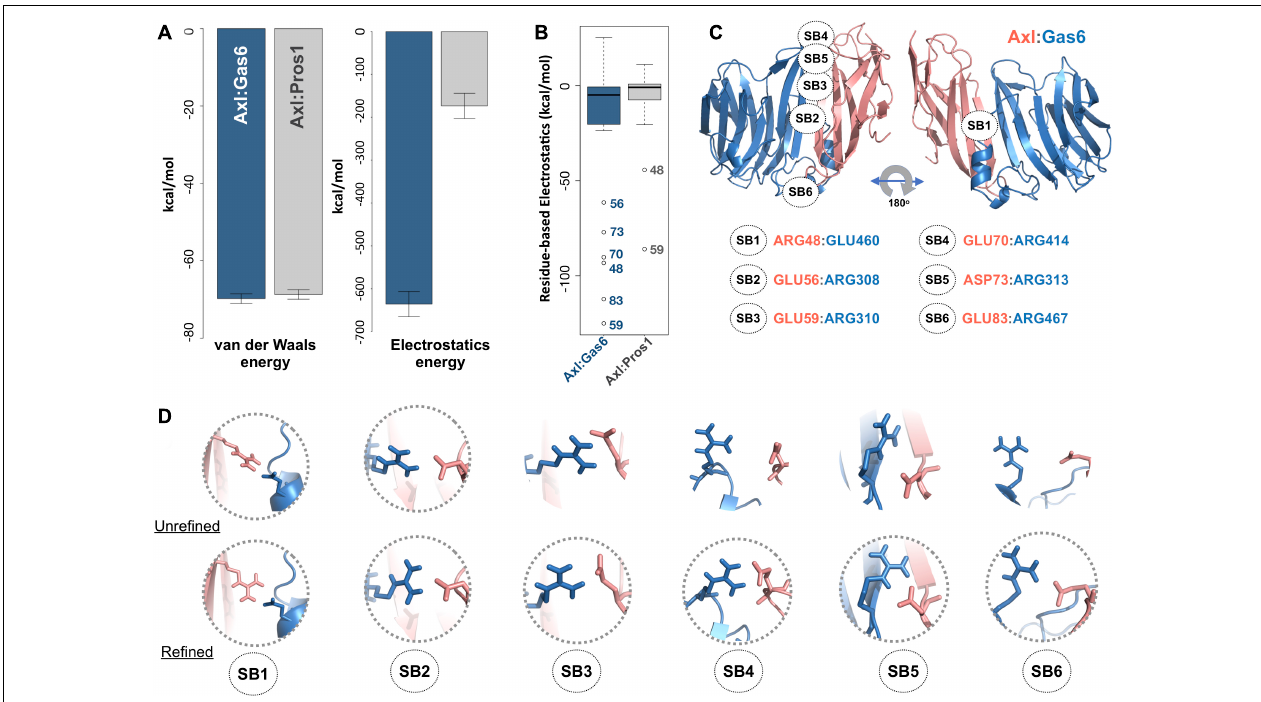
FIGURE 2 | (A) The mean van der Waals and electrostatics energetics of the top scoring Axl:Gas6 and Axl:Pros1 major interfaces calculated by HADDOCK. The mean van der Waals energies of Axl:Gas6 (blue) and Axl:Pros1 (gray) are –69.8 ± 1.2 kcal/mol and –68.9 ± 2.2 kcal/mol, respectively. The mean electrostatics of Axl:Gas6 and Axl:Pros1 are –635.8 ± 29.3 kcal/mol and –173.5 ± 21.4 kcal/mol, respectively. (B) Residue-based electrostatics contribution of Gas6-facing Axl residues. Axl residues behaving differently than the rest of the population are R48, E59, E70, D73, E83 in the case of Axl:Gas6 (blue), and E48, E59 in the case of Axl:Pros1 (gray). The whiskers were computed with a whisker length of 2xIQR. (C) The distribution of the salt bridges (SBs) across Axl:Gas6 interface. Axl is represented in light pink and Gas6 in marine blue. Only SB1 is located on the back and rather neutral side of the complex. This and all the structural images were generated with PyMOL molecular visualization software (Schrödinger, 2015). (D) The arrangement of the potential SB-making residues in the case of crystal (first row, pdb id: 2C5D) and HADDOCK-refined (second row) Axl:Gas6 complex. The pairs forming SBs are encircled.